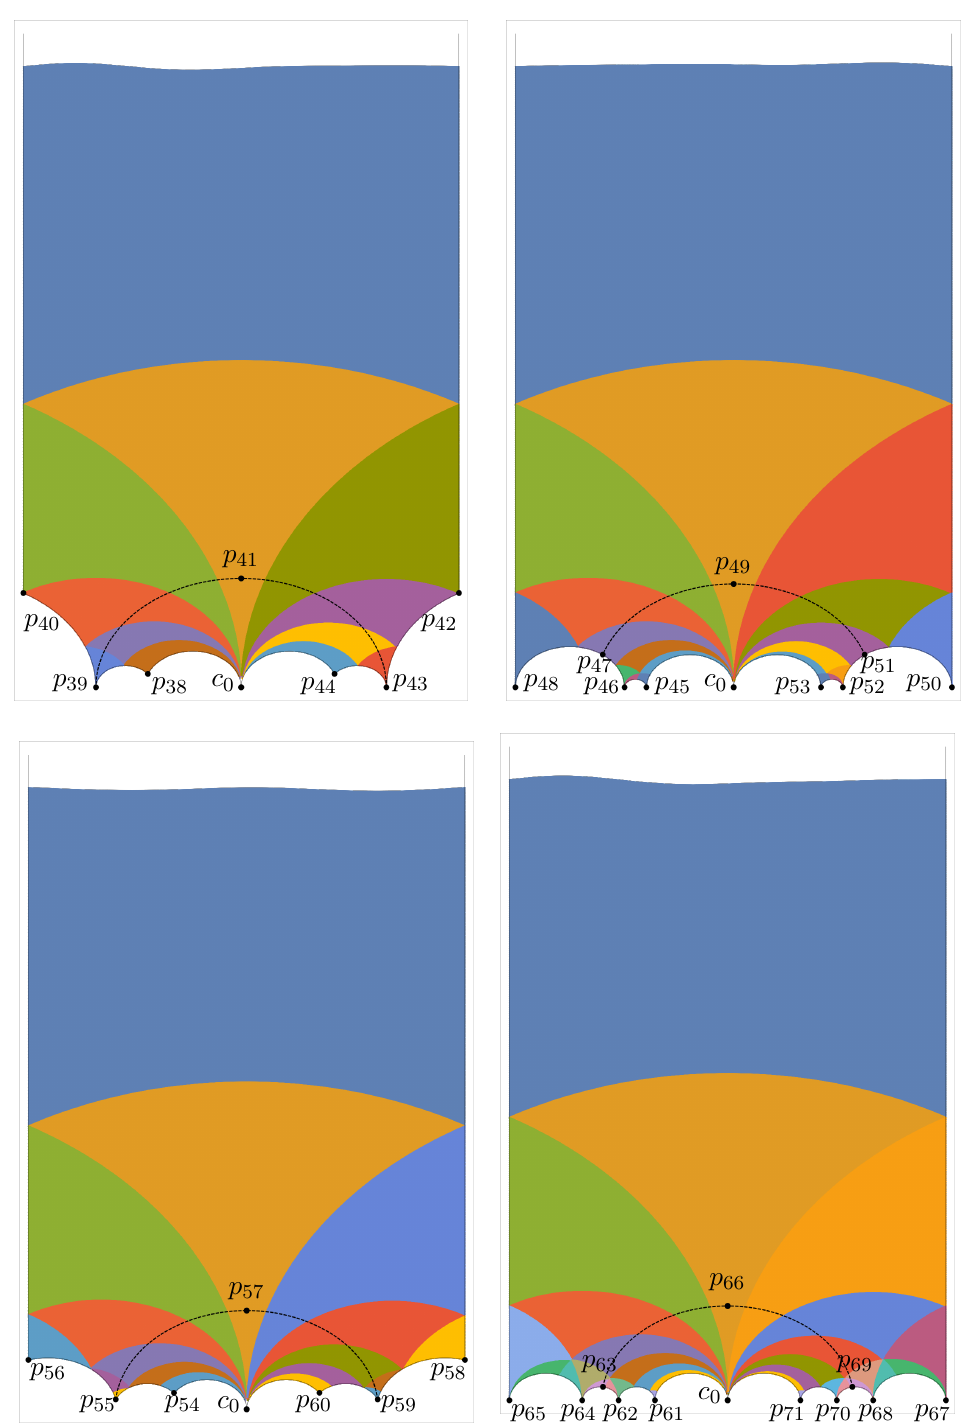
Figure 10 . Symmetric fundamental domains for Γ 0 ( N ) with N = 9 , 10 , 11 , 12 . The labelled points are listed in table